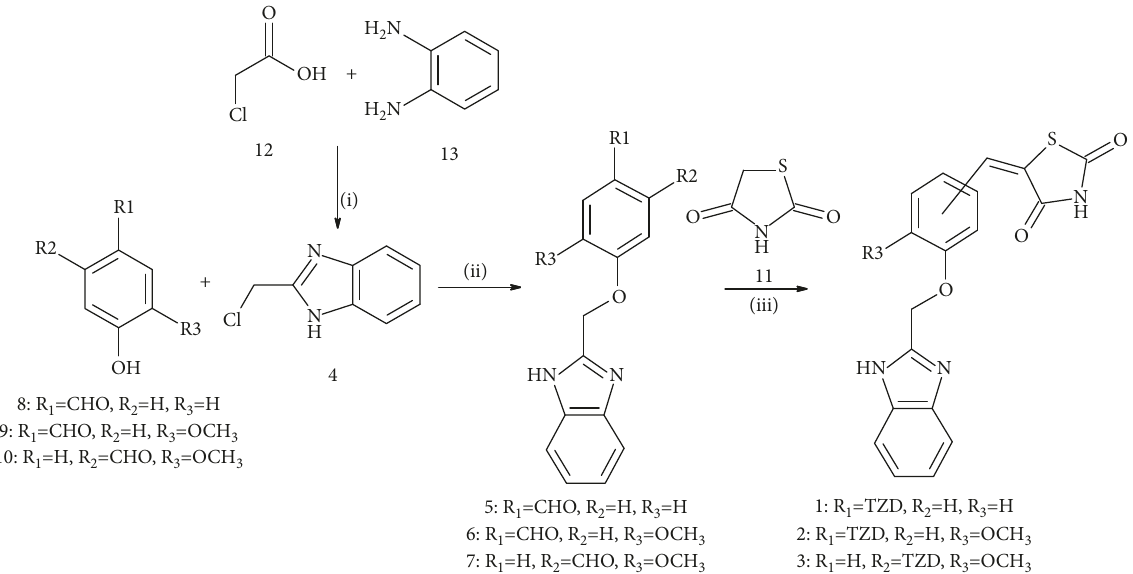
Figure 2: Synthesis of compounds 1–3 : (i) HCl 1M reflux; (ii) K Dean–Stark